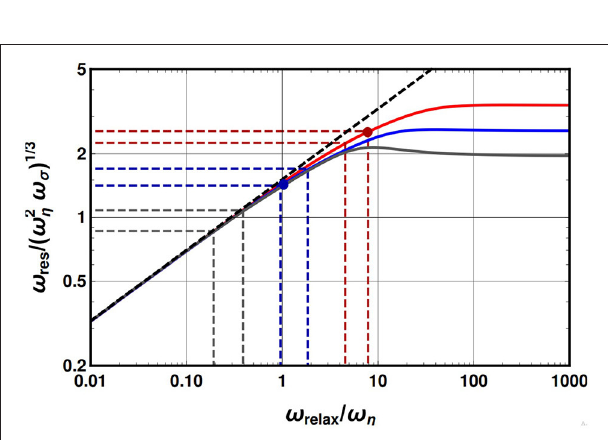
FIGURE 10 | Illustration for the way of estimating the value of relaxation time (through ω relax ) by visual estimation of the resonance frequency, and its corresponding error bars. The theoretical model predicts a relation between resonance frequency and relaxation frequency that can be exploited to validate or estimate relaxation times. We have used PEO1 solution (red dashed lines), and PEO5 solution (blue dashed lines) to validate the method. Then we have used the method to estimate the relaxation of the PEO8 solution, from its experimental resonance (gray dashed lines). Red and blue intervals, marked with dashed lines, are in agreement with theoretical data of resonance frequency and relaxation times (placed as a circle red dot) for PEO1 and (placed as a circle blue dot) for PEO5. Black dashed line represents an approximated relation for ω res in Equation (13). Continuous lines are exact results for resonance, obtained by numerical